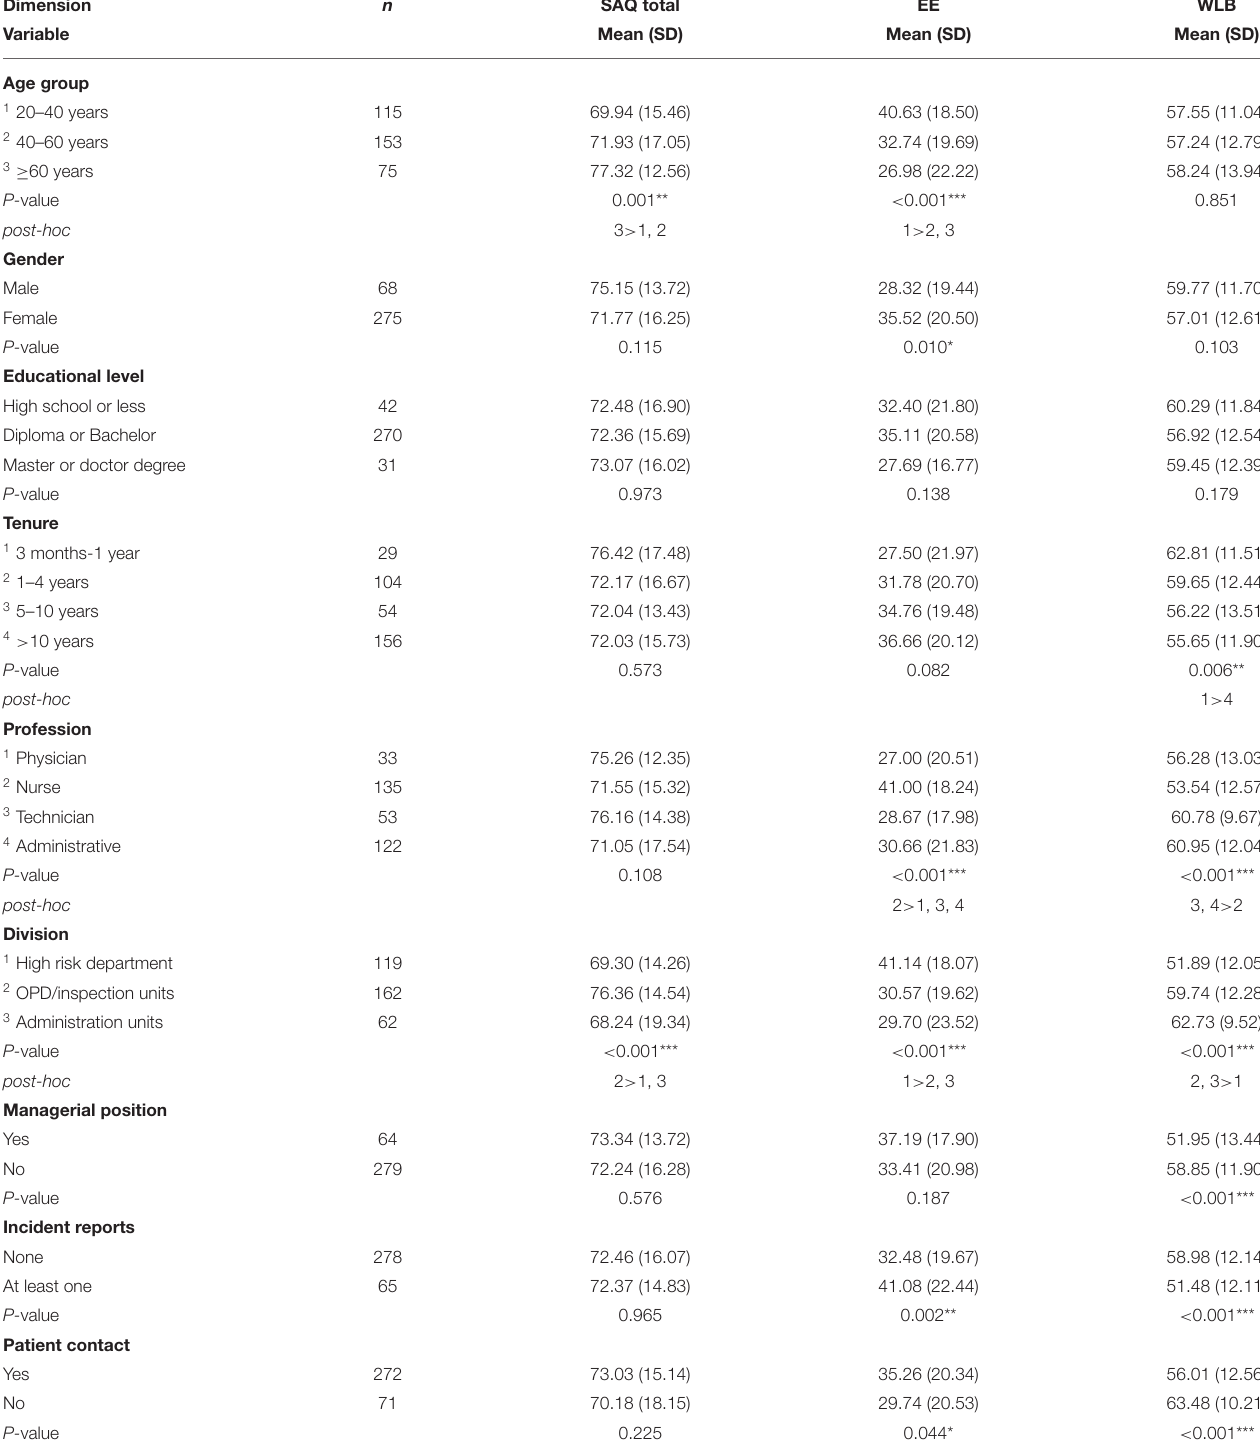
TABLE 4 | Bivariable analysis of demographic and SAQ, EE, WLB.